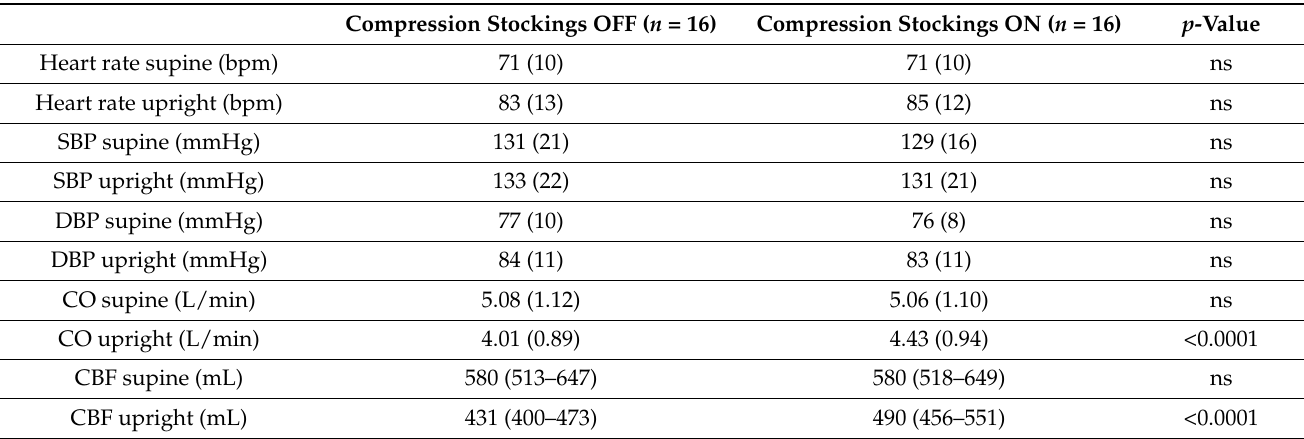
Table 1. Hemodynamic baseline characteristics.